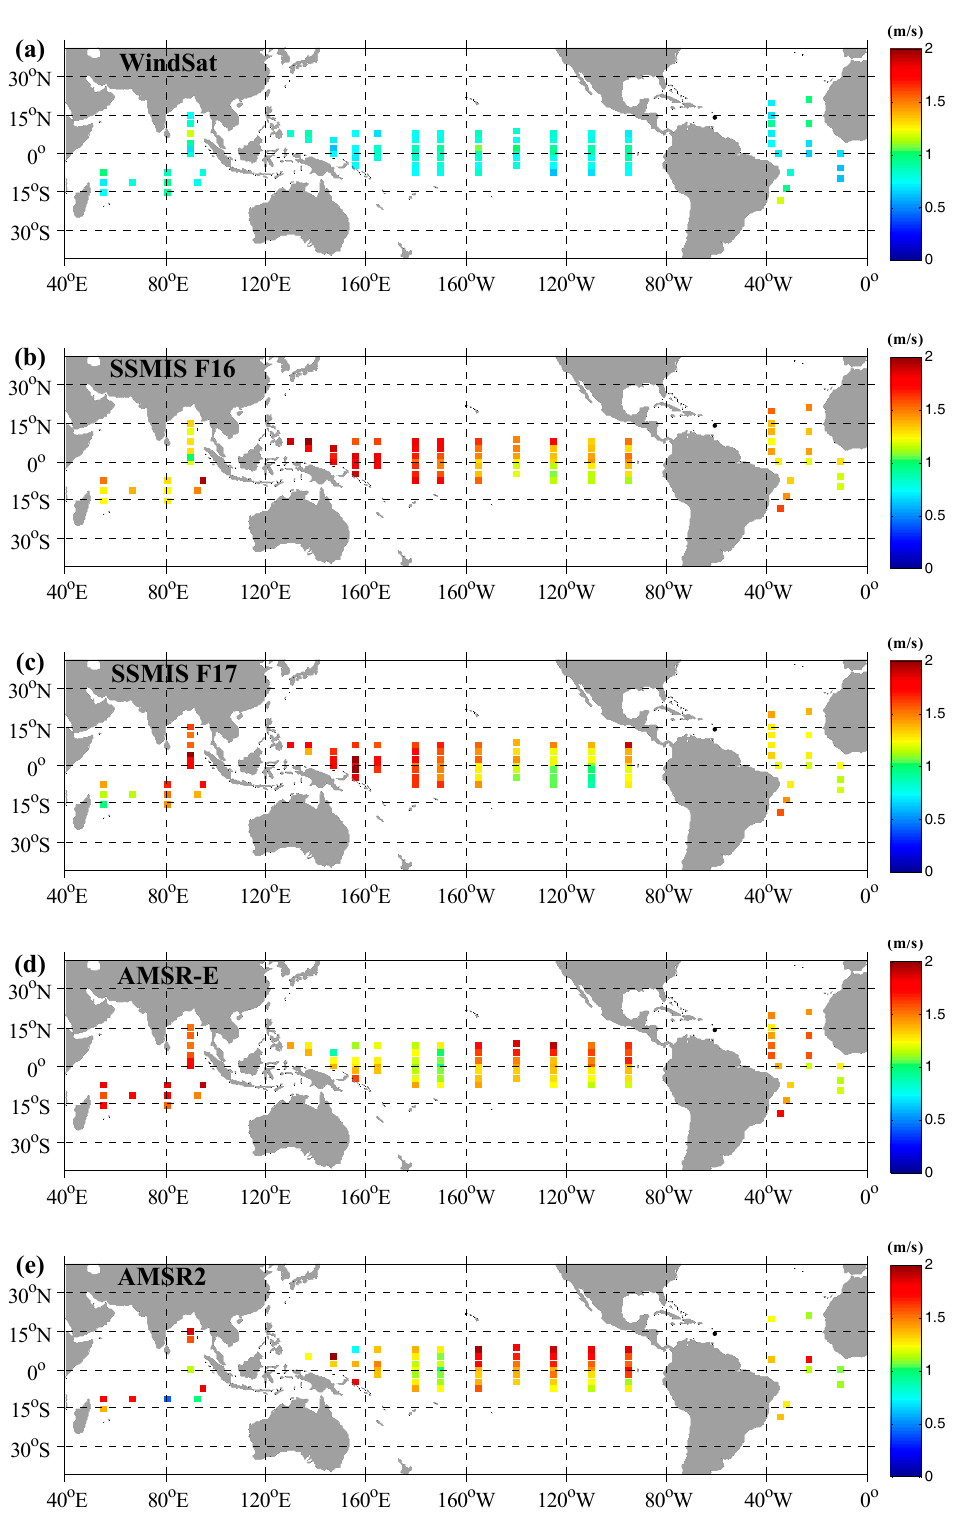
Figure 4. The RMSE of wind speeds between satellite retrievals and buoy observations at each buoy site: ( a ) WindSat; ( b ) SSMIS F16; ( c ) SSMIS F17; ( d ) AMSR-E; and ( e )